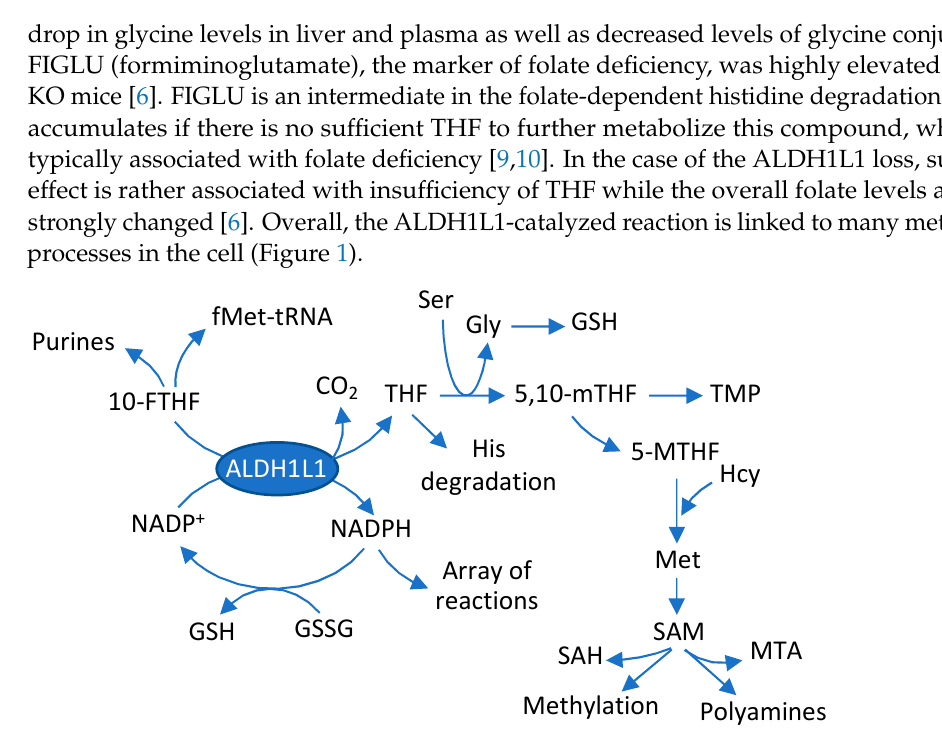
Figure 1. ALDH1L1-catalyzed reaction and downstream metabolic pathways. The immediate downstream processes linked to ALDH1L1 are: biosynthesis of purine nucleotides; formylation of Met-tRNA (the reaction required for the initiation of protein biosynthesis in mitochondria); the generation of THF; and the NADPH production. THF is required for glycine biosynthesis from serine and histidine degradation. Downstream of glycine synthesis are shown GSH, TMP and SAM biosynthesis; SAM is linked to the variety of methylation reactions and polyamine biosynthesis. The role of NADP + /NADPH is widespread in the cell; as the example, the NADPH-dependent reduction of oxidized glutathione (GSSG) is shown. GSH, reduced glutathione; THF, tetrahydrofolate; 10-FTHF, 10-formyl-THF; 5,10-mTHF, 5,10-methylene-THF; 5-MTHF, 5-methyl-THF; TMP, thymidine monophosphate; SAM, S-adenosylmethionine.